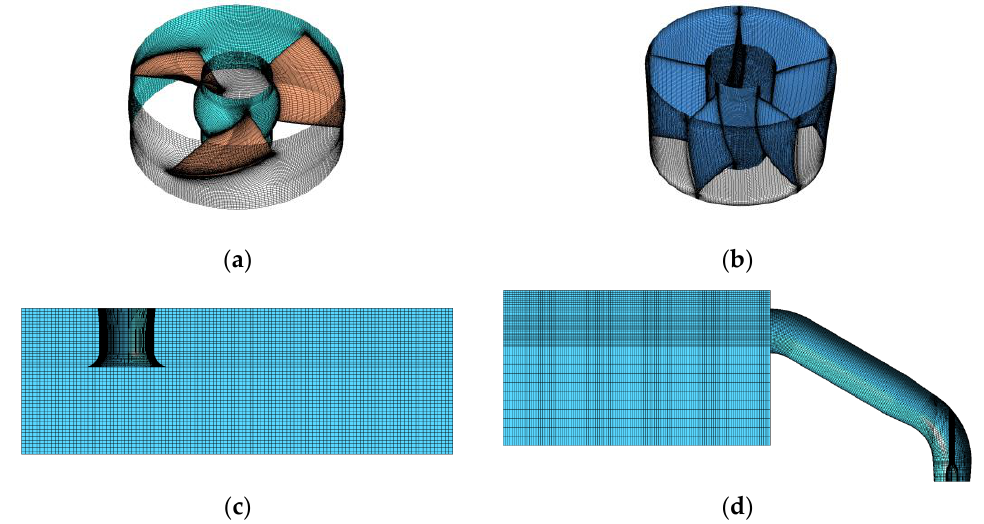
Figure 4. Grid generation. ( a ) Impeller. ( b ) Guide vane. ( c ) Closed sump. ( d ) Outlet pipe and pressure tank pressure tank.